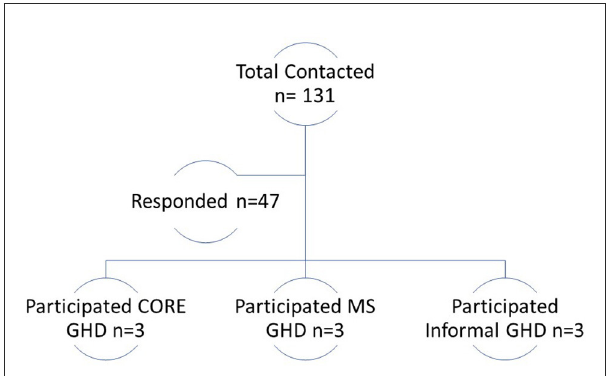
FIGURE1 Participants included in the interviews that met inclusion criteria divided according to the Pyramid of Global Health Diplomacy. CORE: diplomatic professionals; health attachés and represent coordination focal points. MS: government agencies or entities